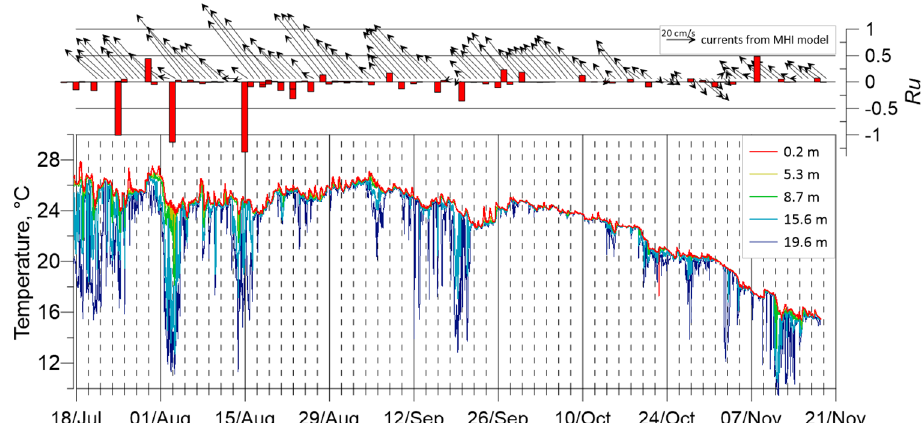
Figure 7. Water temperature, upwelling criteria and direction of currents during second measurement period from 18 July 2020 to 19 November 2020.